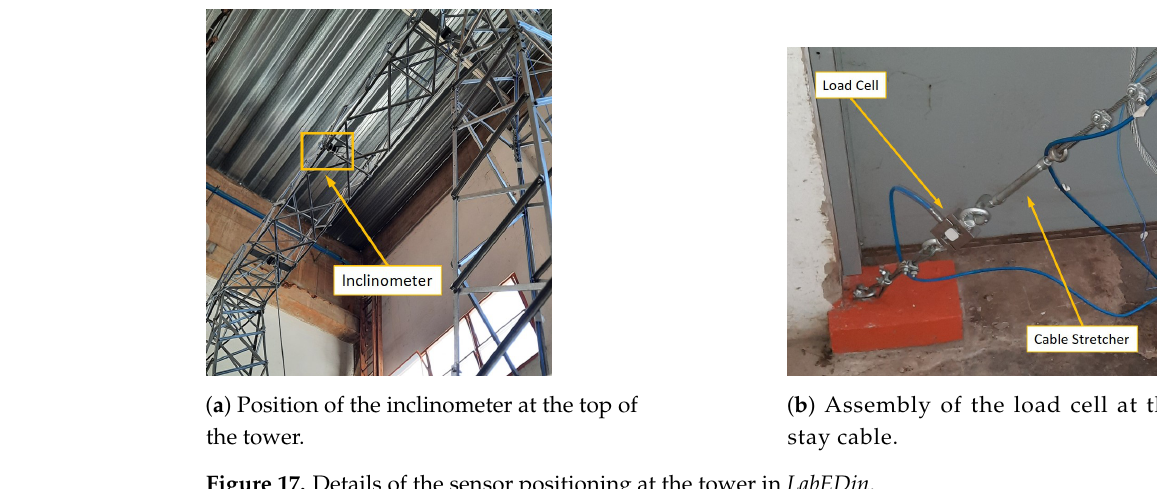
Figure 17. Details of the sensor positioning at the tower in LabEDin . Figure 18 illustrates the simplified mathematical model of the mockup tower.